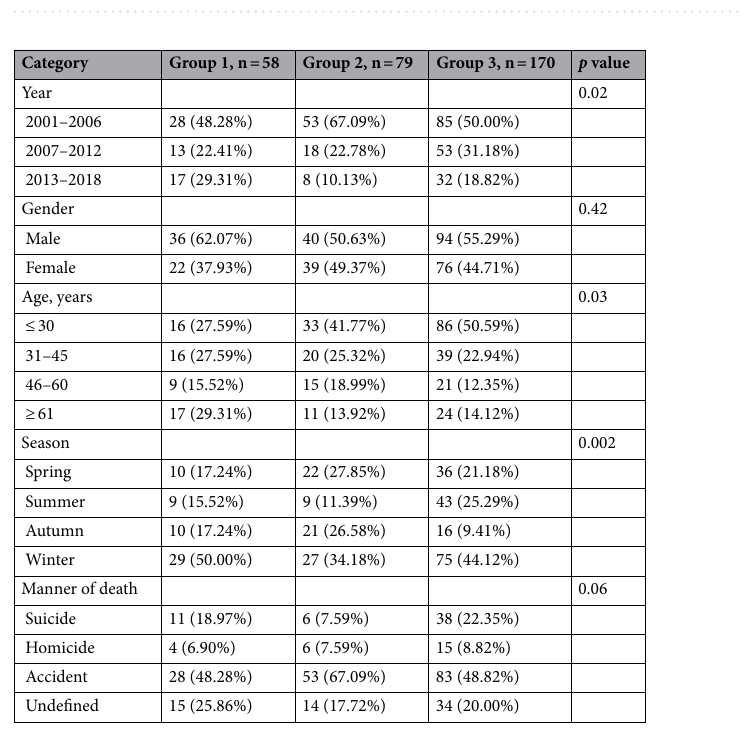
Table 2. Distribution of CO poisoning cases by epidemiologic and demographic